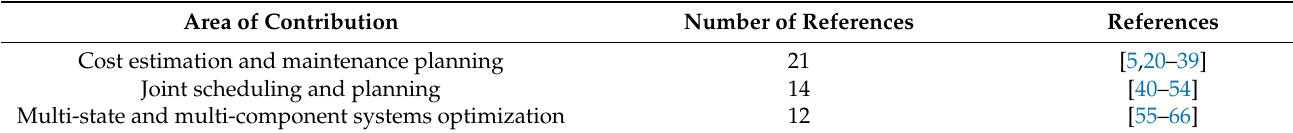
Figure 2. The categories of methods for each area of contribution. Table 3. Areas of decision-making algorithms in manufacturing maintenance.